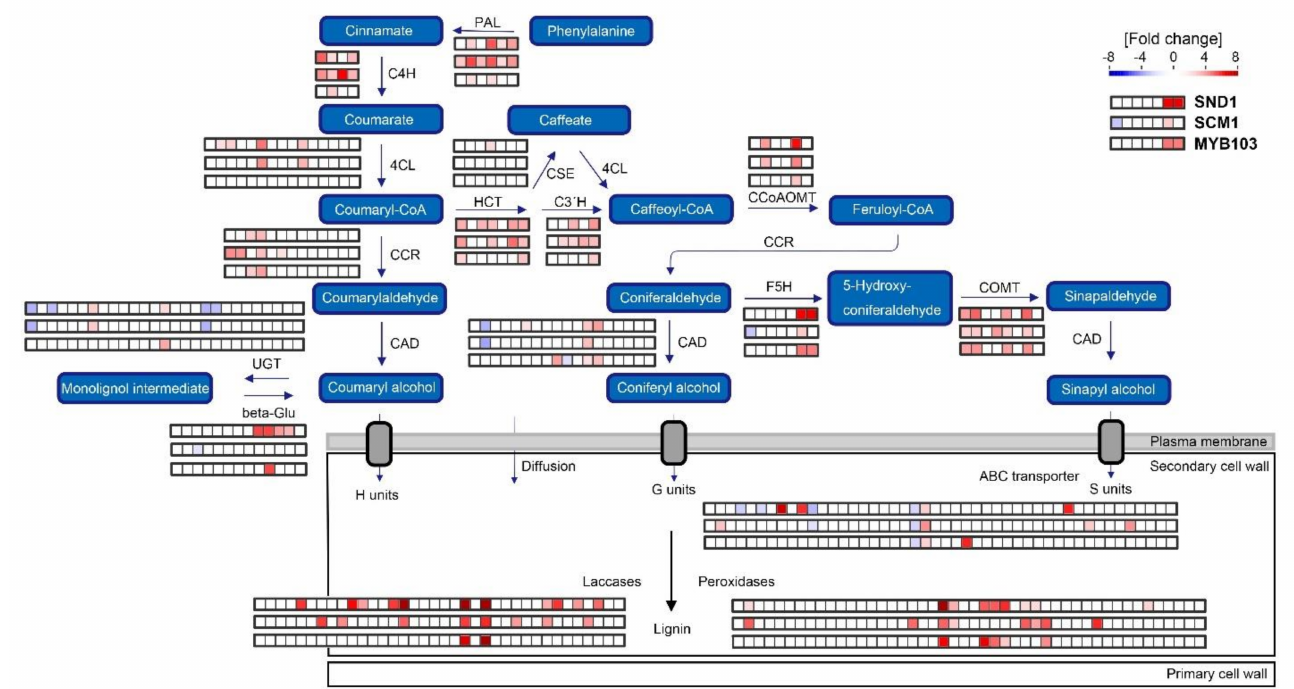
Figure 8. A schematic overview of lignin biosynthesis pathway and DEGs regulated by MsSND1, MsSCM1, and MsMYB103. The fold change of putative genes involved in lignin biosynthesis according to functional annotation by [40]) are represented in colored squares, generated by MapMan software [41]. The rows of squares visualize the three samples, MsSND1, MsSCM1, and MsMYB103, respectively. Red indicates upregulation, while blue indicates downregulation. The key in the upper right part of Figure uses the F5H expression data as example. 4CL, 4-coumarate CoA ligase; beta-Glu, β -Glucosidase; C3 (cid:48) H, p-coumaroyl shikimate 3 (cid:48) -hydroxylase; C4H, cinnamate 4-hydroxylase; CAD, cinnamyl alcohol dehydrogenase; CCoAOMT, caffeoyl CoA O-methyltransferase; CCR, cinnamoyl CoA reductase; COMT, caffeic acid O-methyltransferase; CSE, caffeoyl shikimate esterase; F5H, ferulate 5-hydroxylase; HCT, hydroxycinnamoyl CoA:shikimate hydroxycinnamoyl transferase; PAL, phenylalanine ammonia lyase; and UGT,